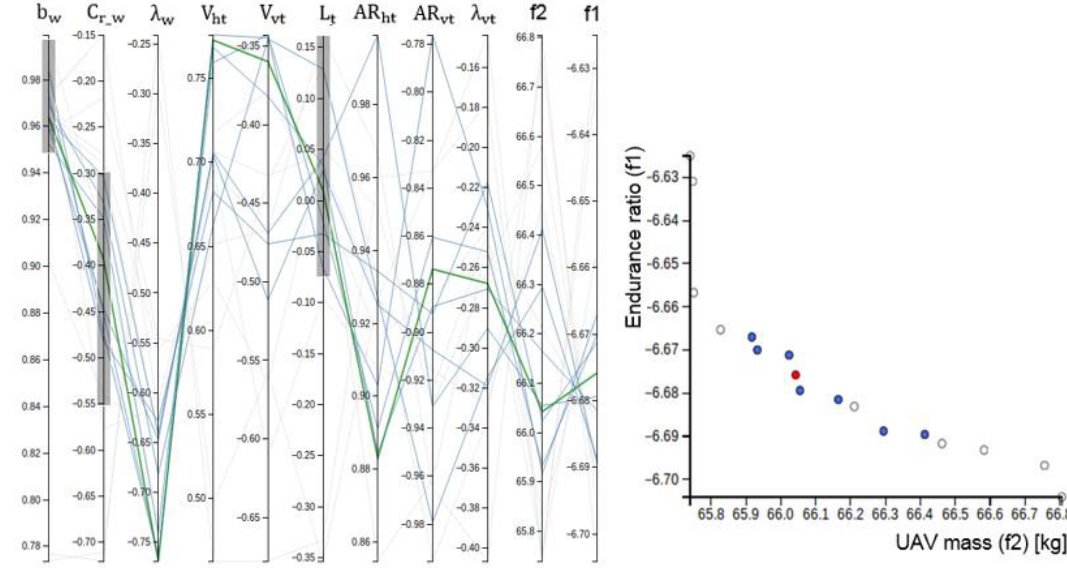
Figure 3. Particle selection schema, selection of objective functions on parallel coordinates and its location highlighted on the Pareto front using a scatter plot.